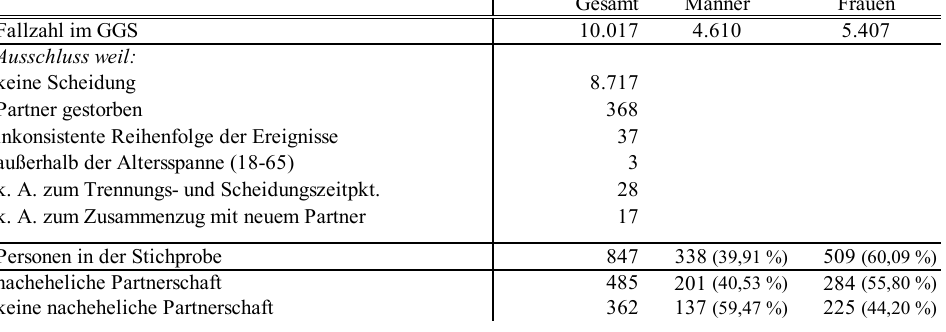
Tabelle A1: Anzahl der in die Analyse ein- und ausgeschlossenen